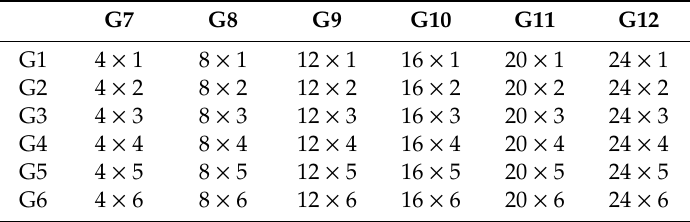
Table 7. Parameters associated with the crack specimen. (cl × cd, cw = 0.5 mm) (mm).